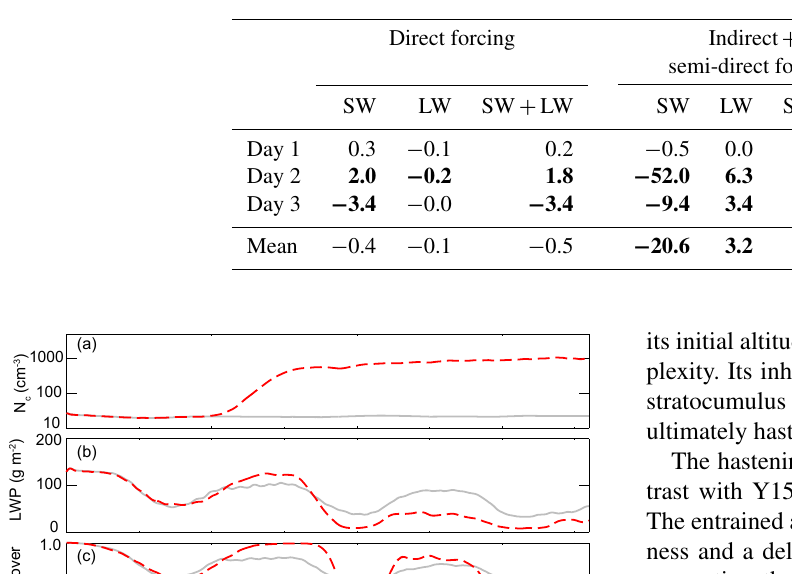
Table 10. As in Table 9 but for a heavily drizzling baseline ( N a , sulfate = 25mg − 1 ).